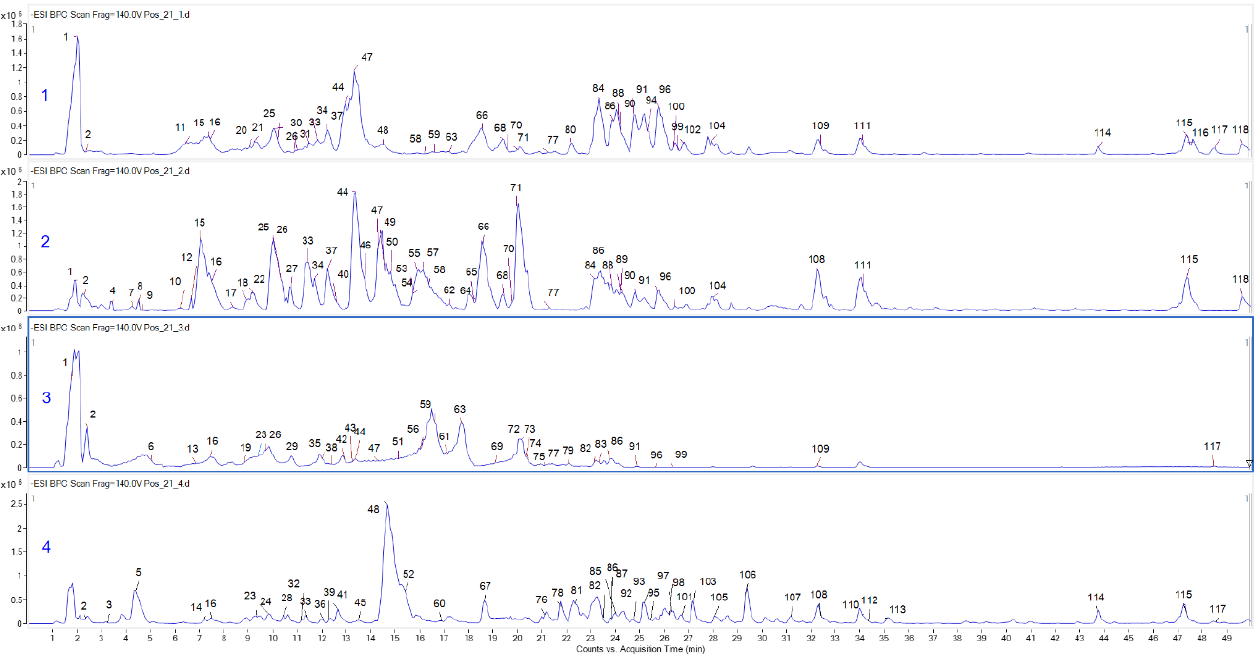
Figure 1. Base peak chromatograms of studied extracts. 1 Ficus sur leaves-MeOH; 2 Ficus sur leaves-infusion; 3 Ficus sur stem bark -MeOH; 4 Ficus sur stem bark -infusion.